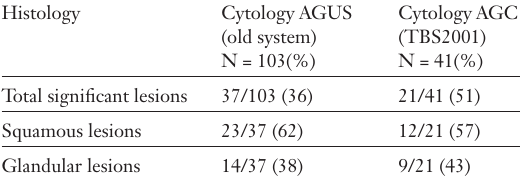
Clinically significant lesions in AGUS and AGC